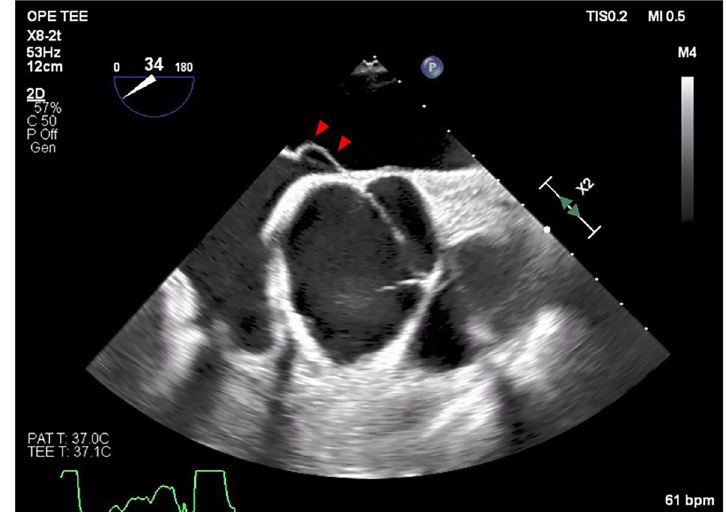
Fig. 2 Intraoperative transesophageal echocardiography: aortic valve short axis view. An atrial septal aneurysm with a 10-mm deviation of the atrial septal tissue into the left atrium